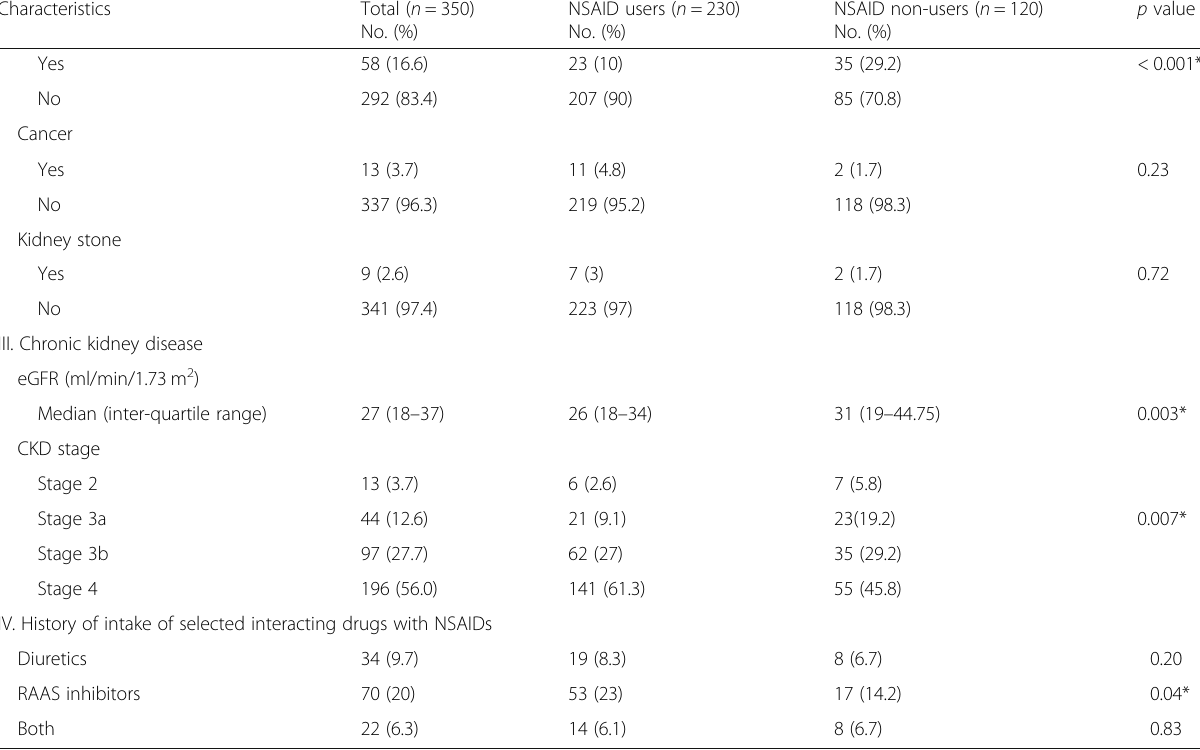
Table 1 Characteristics of the study CKD patients, Alexandria Main University Hospital, Egypt, 2016 (Continued)